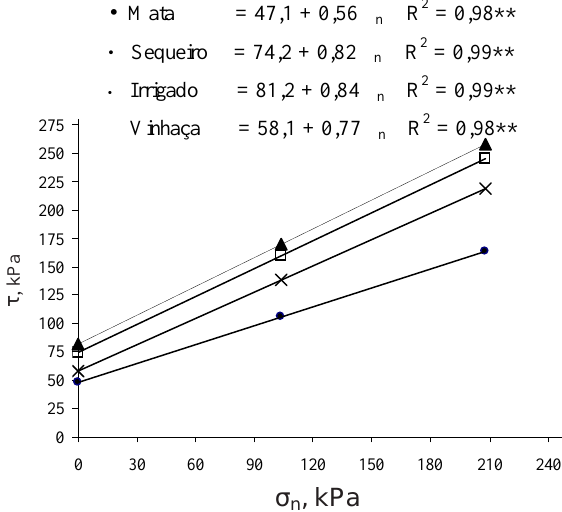
Figura 5. Resistência ao cisalhamento ( τττττ ) de acordo com a tensão normal ( σσσσσ ) na camada de 0,2– n 0,4 m e teor de água de 0,11 kg kg -1 para os sistemas de manejo